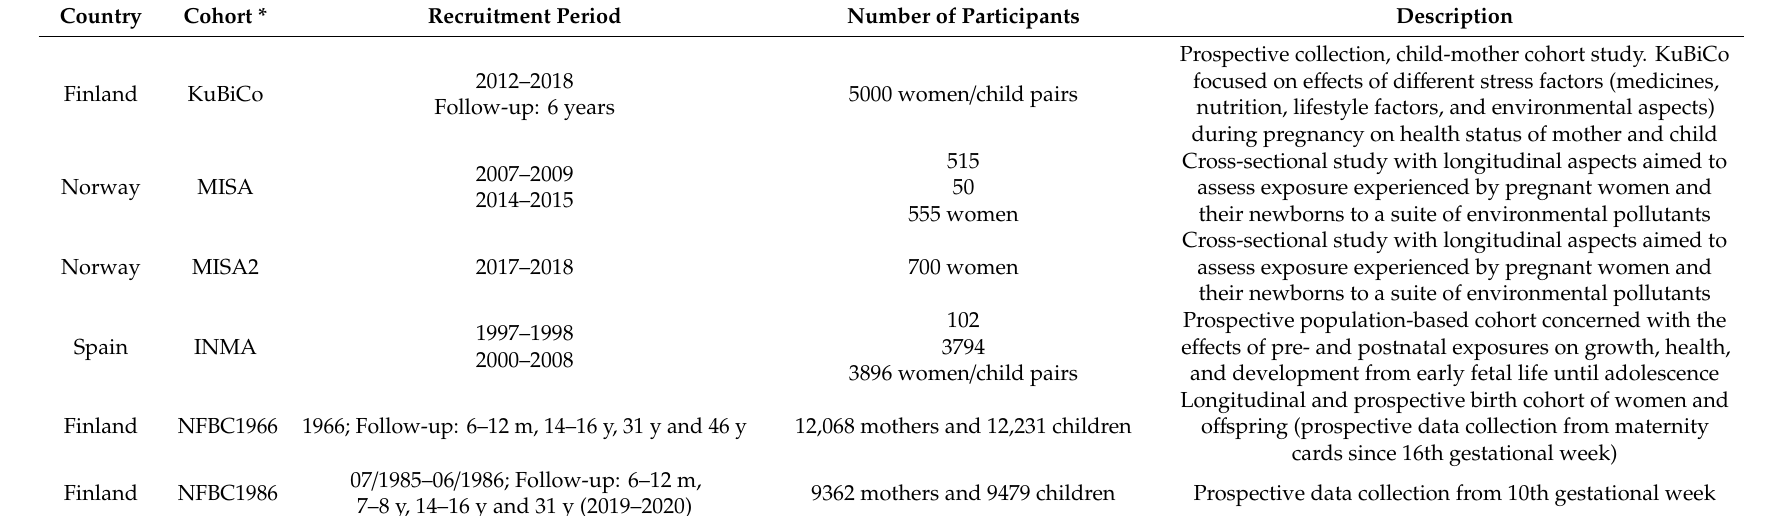
Table 2. Overview of epidemiological cohorts connecting environmental exposure to metabolic disorders in the EDCMET project.